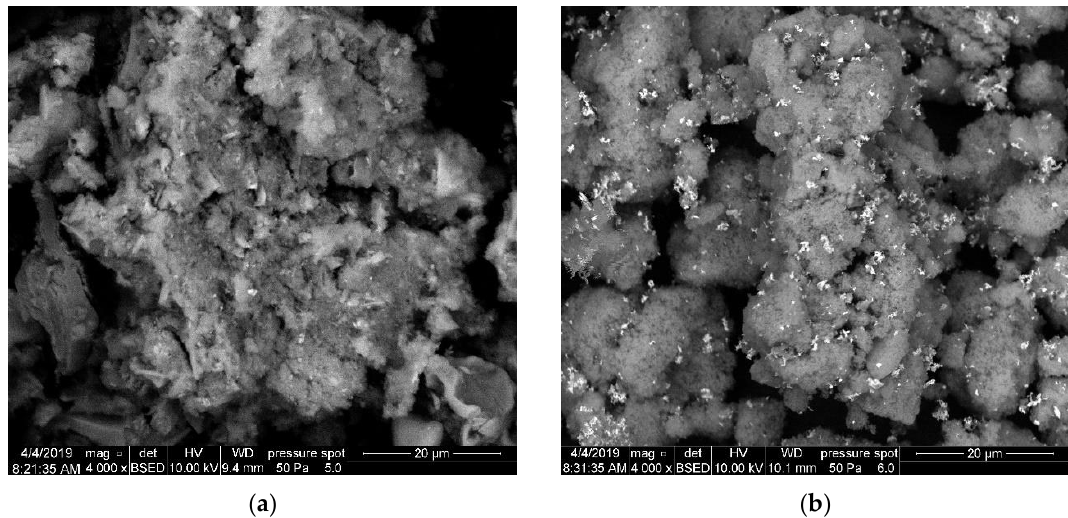
Figure 2. Backscattered electron images of: ( a ) silicate substrate ZnO· m SiO 2 and ( b ) final antimicrobial material Ag-ZnO· m SiO 2 .